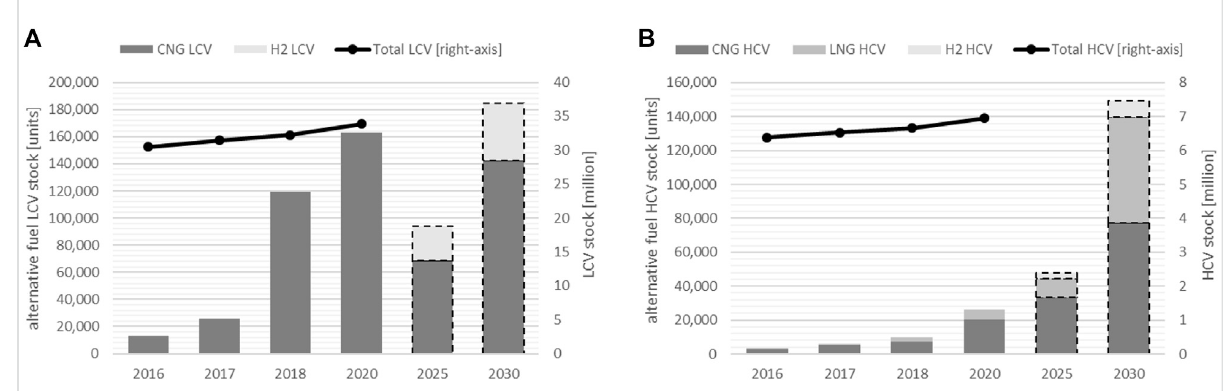
FIGURE 6 Total, natural gas and hydrogen-powered stock and estimates in EU27 + UK: LCV (A) and HCV (B) . Note: the 2025 and 2030 values result from summing the available estimates. Source: adapted from EC (2022), based on NIR and EAFO (2021)